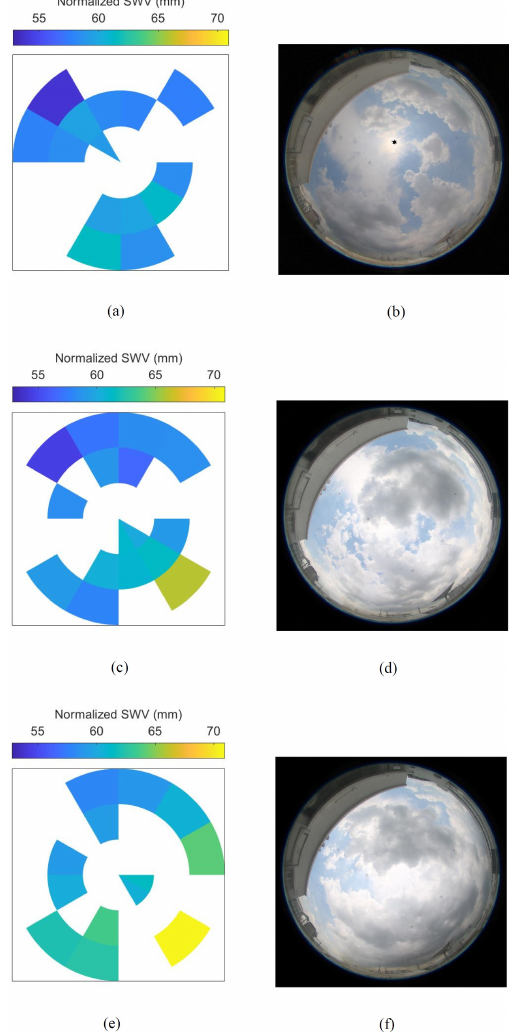
Figure 7. Left: Spatial plots of normalized SWV on 20 April 2016 at ( a ) 13:00, ( c ) 13:20, and ( e ) 13:40 local time. Right: Sky images on the same day, at ( b ) 13:00, ( d ) 13:20, and ( f ) 13:40 local time. Next, the spatial plots of normalized SWV are analyzed for another day and